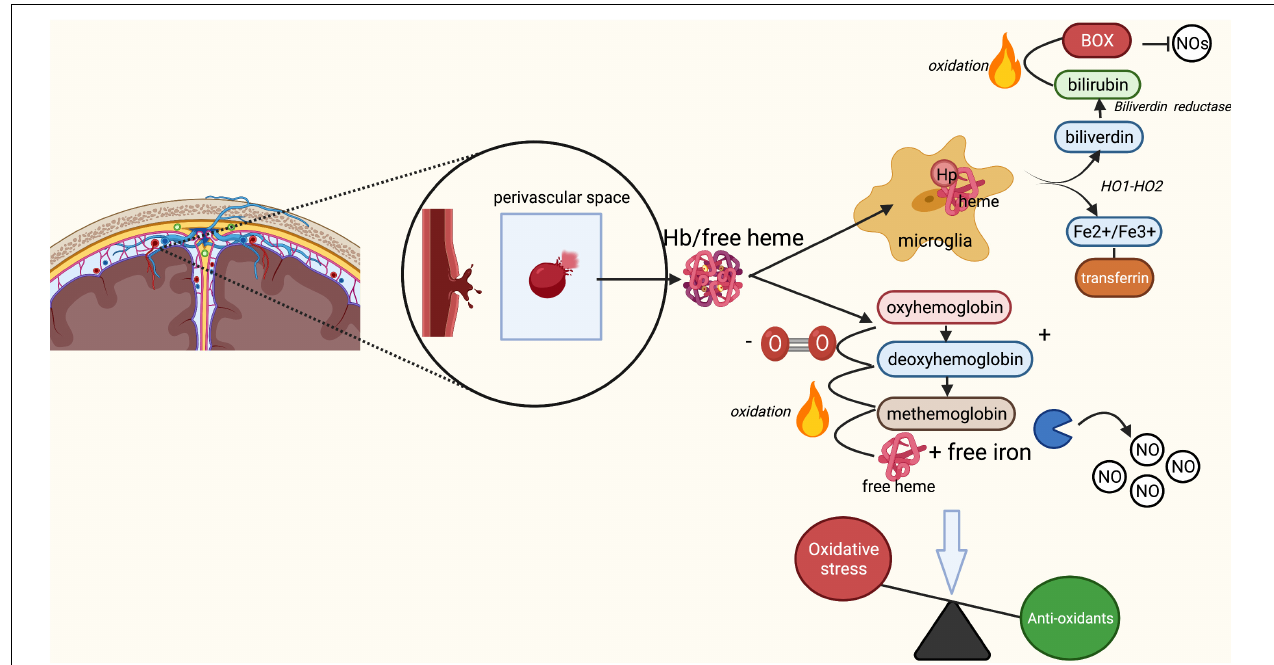
FIGURE 2 | Breakdown of red blood cells following aSAH leading to oxidative stress. Rupture of an intracranial aneurysm results in the extravasation of red blood cells (RBCs) into the subarachnoid space. Here, lysis of the RBCs starts within a few days after the rupture, peaking at 7 days post-rupture. Under physiological conditions, the released free heme and iron from RBCs bind to haptoglobin, forming a Hb-Hp complex. The Hb-Hp complex subsequently attracts microglia and macrophages by the membrane receptor CD163 leading to its phagocytosis and neutralization. End products of this phagocytosis are biliverdin and iron through the action of heme oxygenase 1 and 2. Biliverdin is converted into bilirubin through biliverdin reductase. In the presence of oxygen, biliverdin may turn into bilirubin oxidation products, which act as inhibitors of nitric oxide (NO). Iron may be present in its ferrous (Fe 2 + ) or ferric (Fe 3 + ) form. The ferrous form of iron participates in the Fenton reaction, causing formation of reactive oxygen species and subsequent lipid peroxidation ( oxidative stress) . Under physiological circumstances, the transport protein transferritin and binding protein ferritin prevent iron from causing damage and transport iron back to neurons for later use. In SAH, Hp quickly becomes saturated due to the enormous increase in lysis of RBCs. Unbound Hb turns into oxyhemoglobin, which loses its oxygen and converts to deoxyhemoglobin. Deoxyhemoglobin spontaneously and non-enzymatically converts to methemoglobin, which converts to free heme and iron. Free heme and iron bind NO and contribute to an absolute reduction of NO, and thus a decrease in vasodilation and increase in endothelin-induced vasoconstriction. Finally, free heme and iron contribute to the production of free radicals and lipid peroxides, increasing the overall rate of oxidative stress. BOX, bilirubin oxidation product; Fe 2 + , ferrous iron, Fe 3 + , ferric iron; Hb, hemoglobin; Hp, haptoglobin; HO-1/HO-2, heme oxygenase 1/2; NO, nitric oxide; O 2 , oxygen; ROS, reactive oxygen species. Image is created using